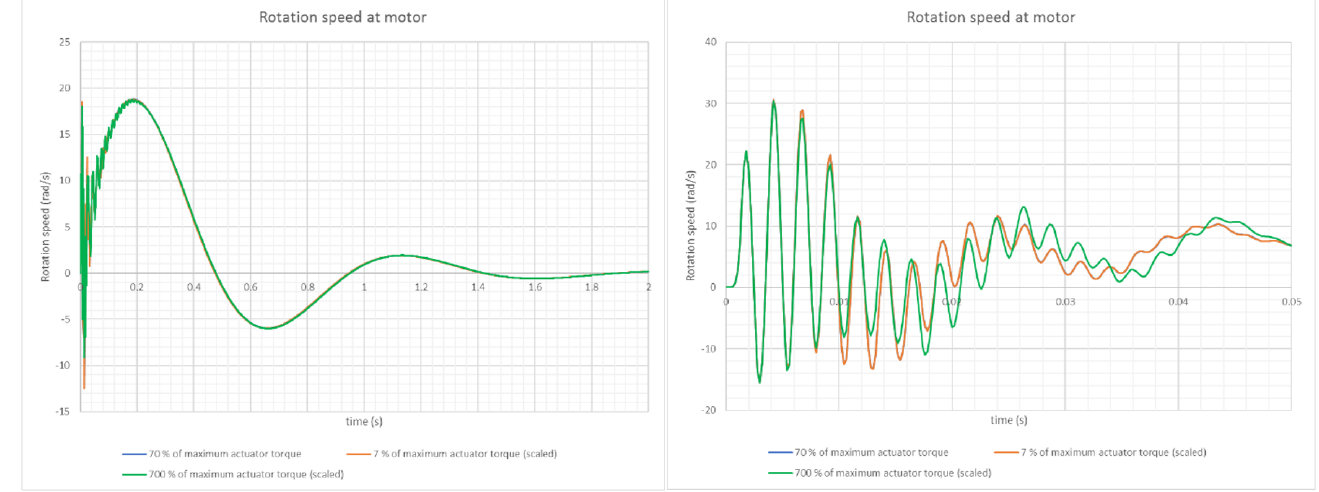
Figure 26. Comparison of disturbance rejection test results for various amplitudes of external excitation, done by OOFE-